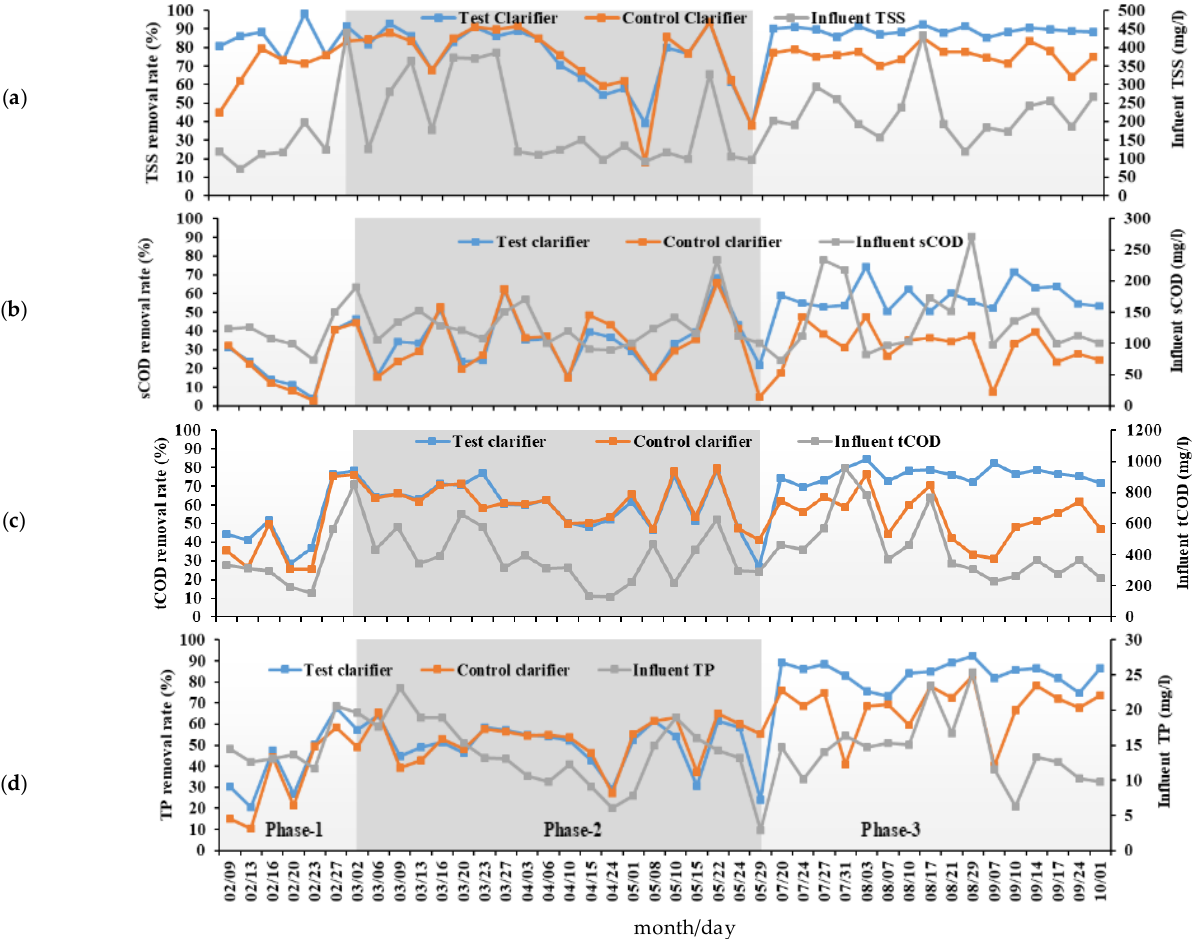
Figure 3. Removal efficiency profile: ( a ) TSS, ( b ) tCOD, ( c ) sCOD, and ( d ) TP removal.